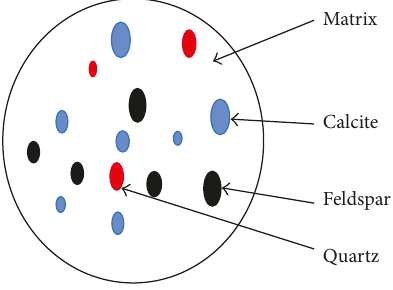
Figure 6: Representative elementary volume (r.e.v.) of the rhyo- dacite